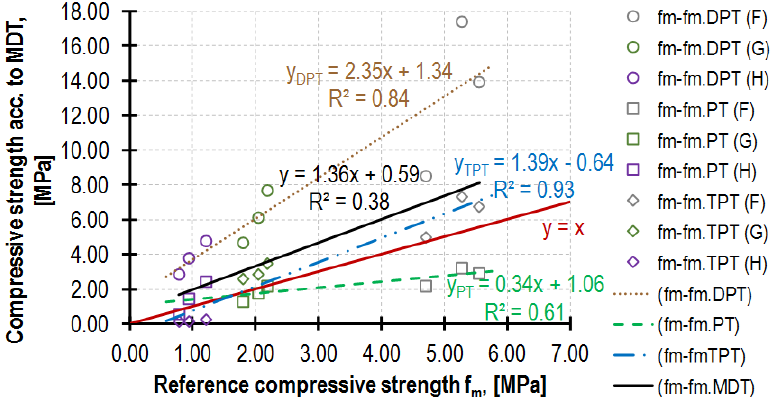
Figure 19. Comparison of mortar strengths obtained by MDTs (e.g., DPT, PT, TPT) and DT (test on 4 × 4 × 8 cm 3 mortar half-beams). The red line separates MDTs that return mortar strength higher than f m (are above) from those which return values lower than f m (are below).